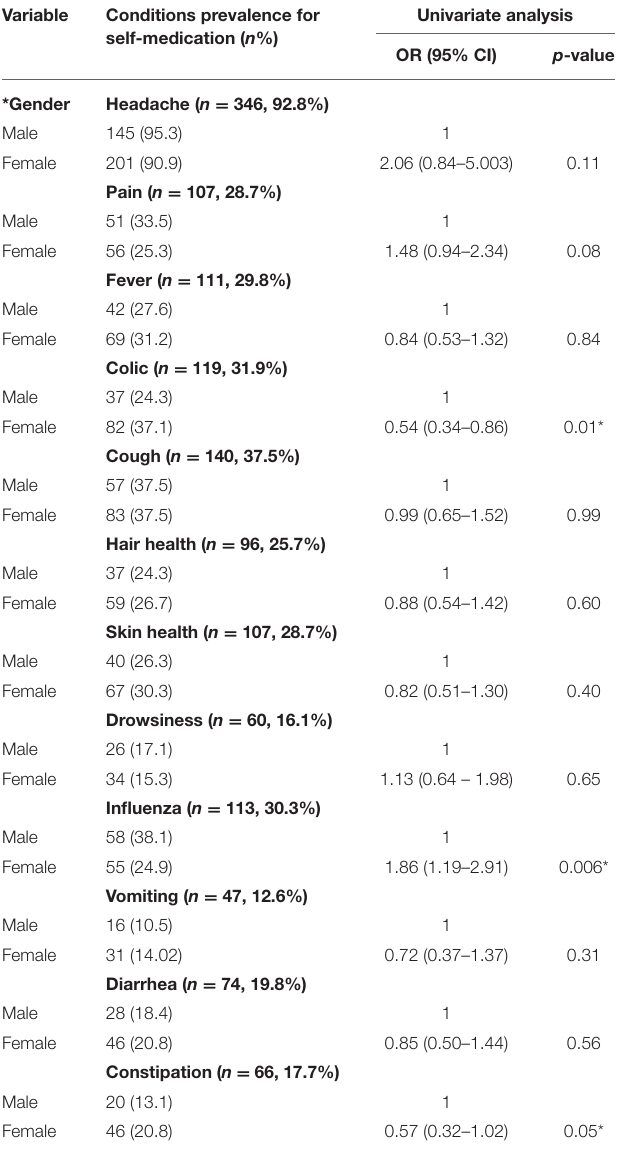
TABLE 3 | Gender related prevalence of self-medication conditions among the study population ( n = 373). Variable